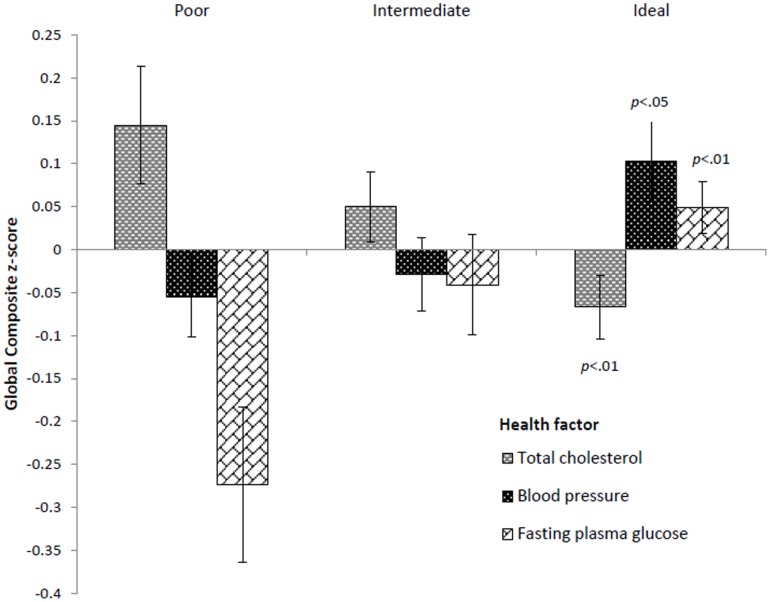
Mean Global Cognition Composite scores according to cardiovascular health level for each health factor.Scores are mean Global Composite z-scores (and standard errors) for poor, intermediate and ideal health categories for total cholesterol, blood pressure, and fasting plasma glucose, adjusted for age, education and gender. p-values are for significant linear trends.